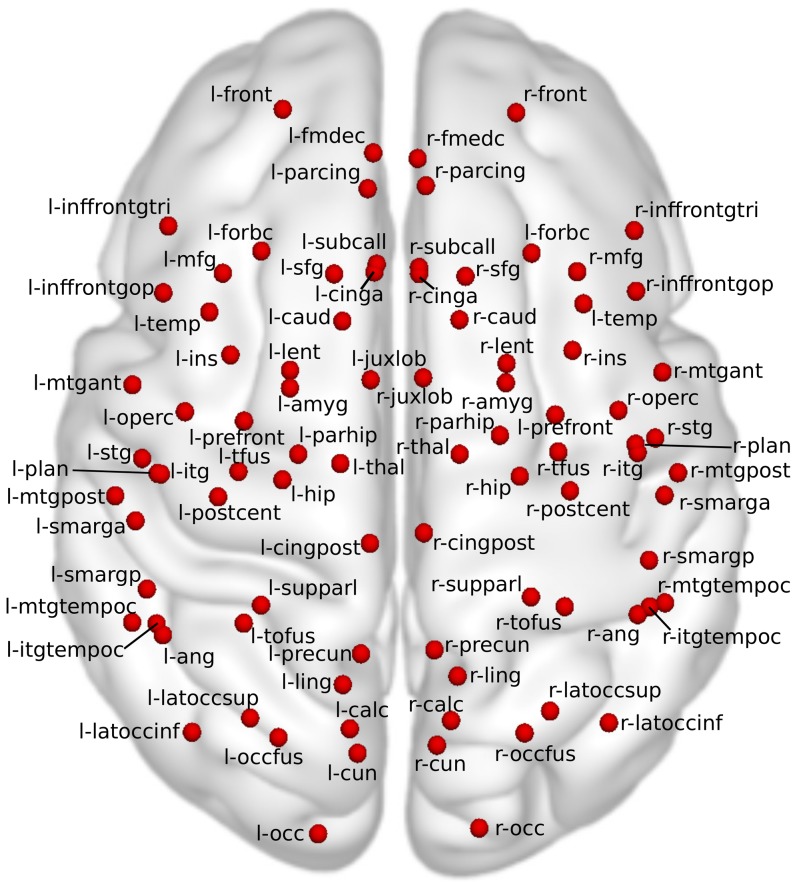
Brain atlas regions.Short names of atlas regions in the glass brain plot used to demonstrate results. Full names and additional information about regions can be seen in Table 1. Red spheres imply the axial projection of the center of mass of brain regions. Note that this plot does not indicate the axial depth of the regions.